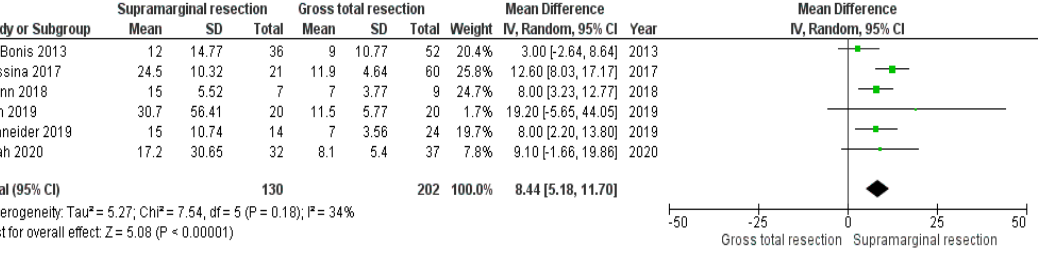
Figure 3. Forest plot with median PFS times and their differences between SMR and GTR [24–29]. X-axis locations of squares represent the mean difference; the bigger the square, the greater the weight due to sample size. The diamond corresponds to the mean difference of the overall data.